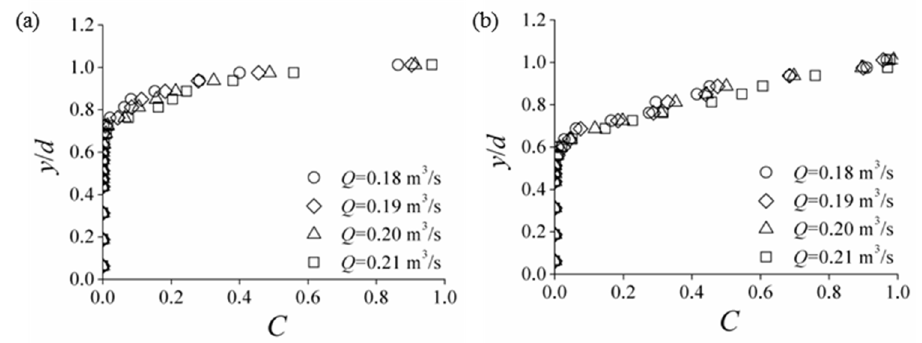
Figure 3. Comparison of air concentration distributions for different flow discharge rates: ( a ) x / d = 40; ( b ) x / d = 90. ( b ) x / d =